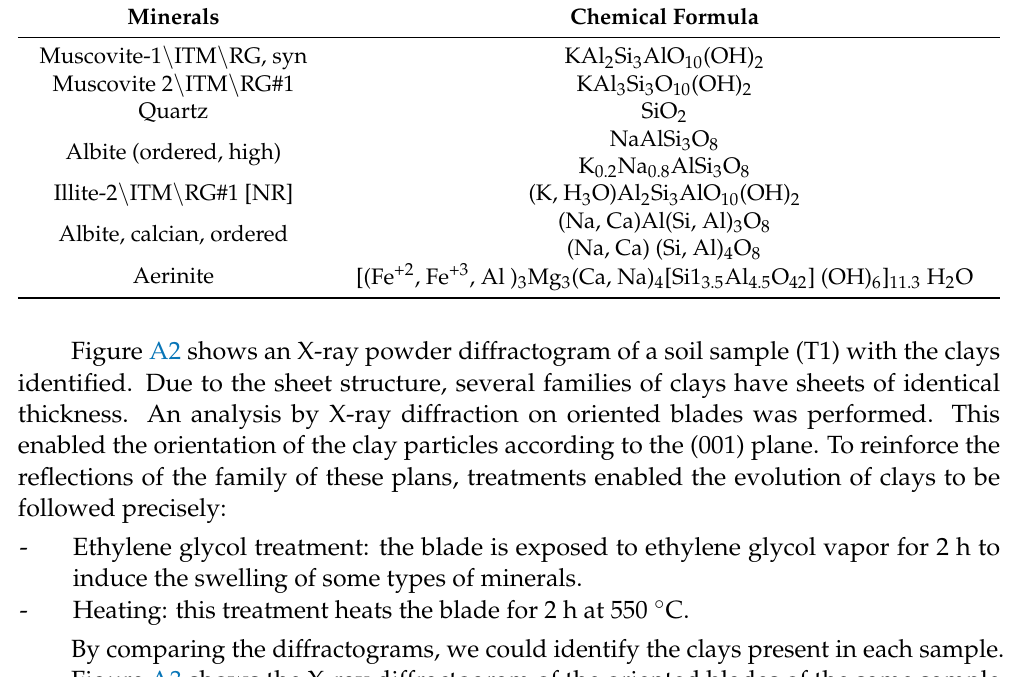
Table 4. Mineral composition of soil samples determined by X-ray diffraction. Minerals Chemical